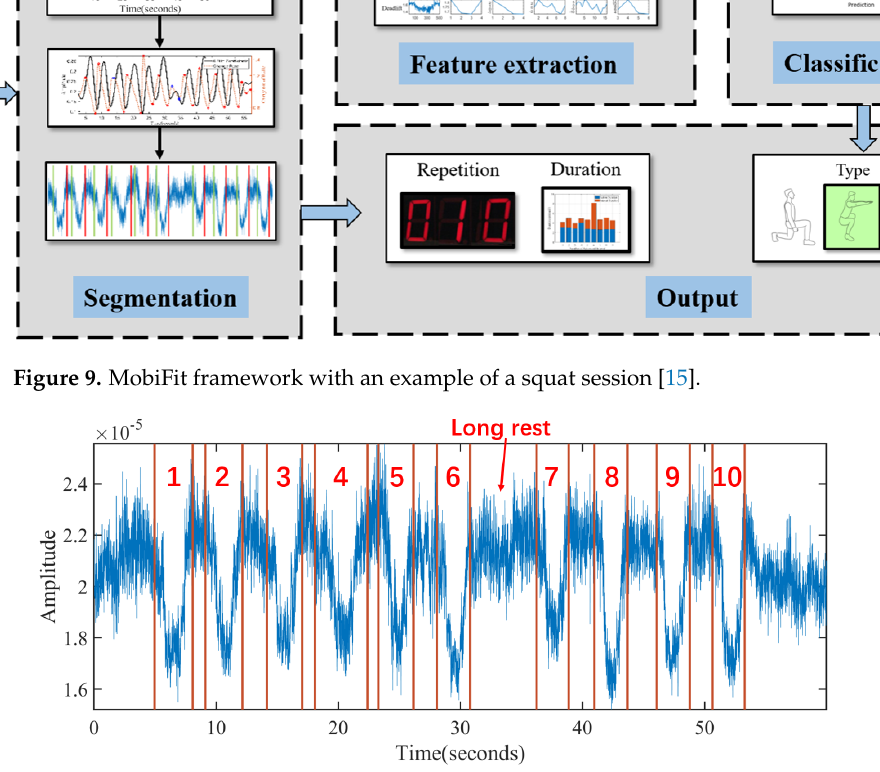
Figure 10. A session of squats performed by a volunteer with red lines and number marking the ground truth of each